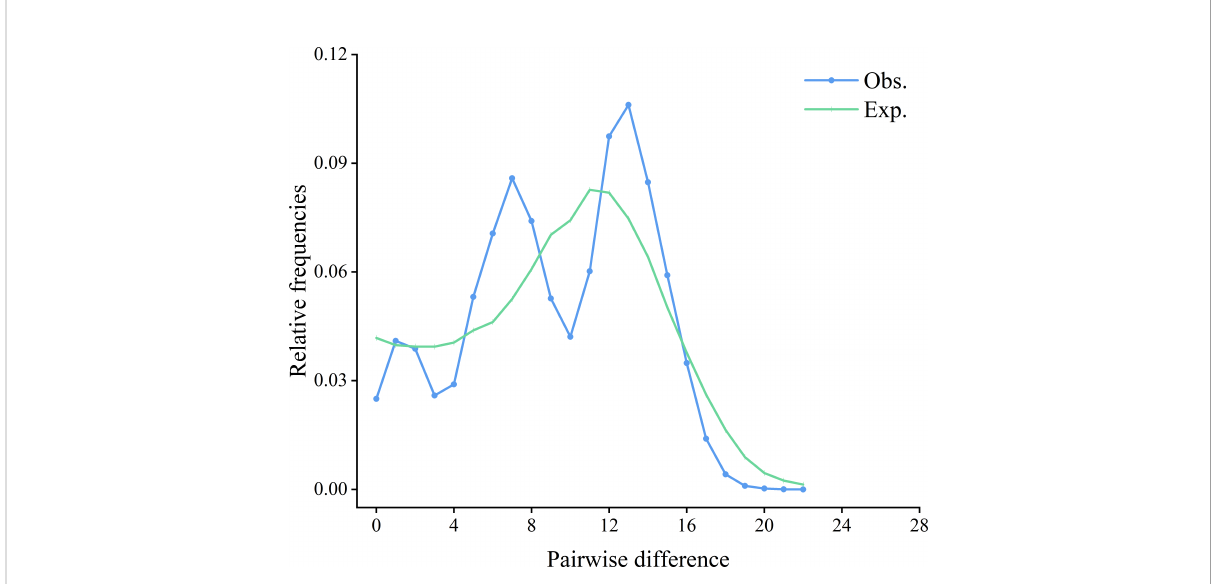
FIGURE 4 Observed ( Obs. ) pairwise differences and expected ( Exp. ) mismatch distributions under the sudden expansion model of the control region of Sebastiscus marmoratus